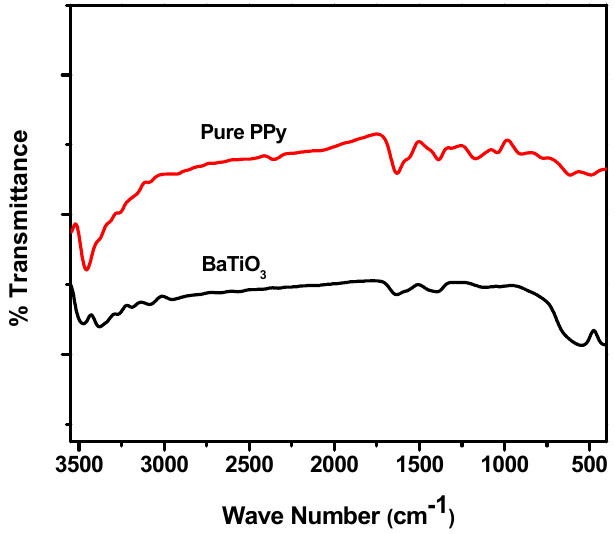
Figure 1. FT-IR spectrum of neat PPy and BaTiO 3.